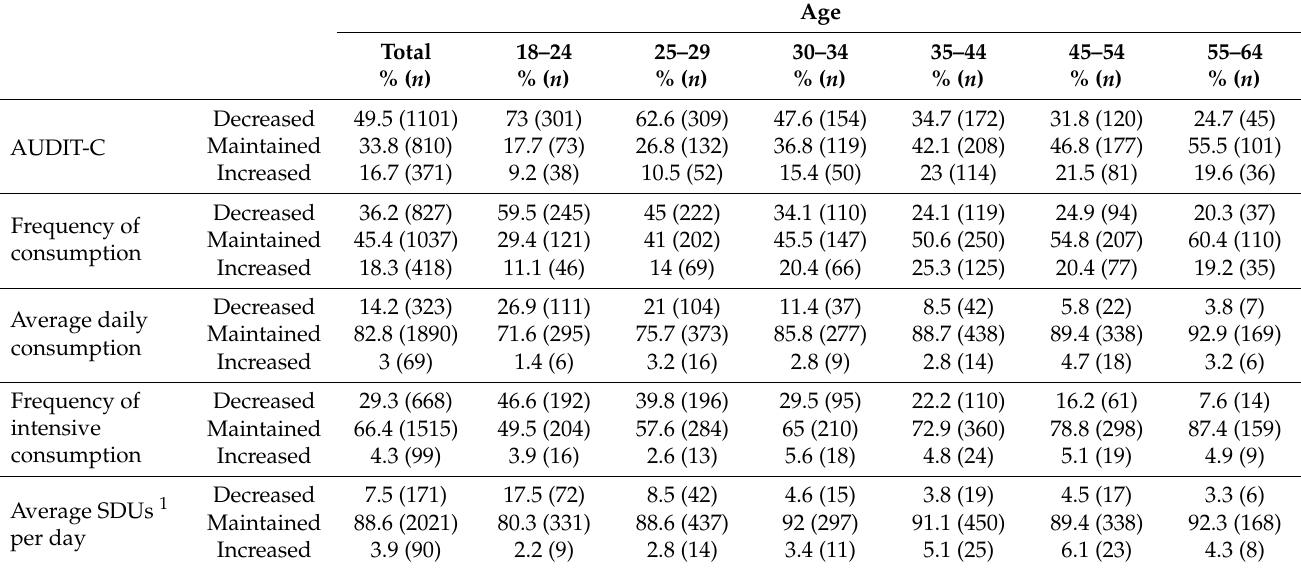
Table 1. Changes in alcohol consumption during confinement ( n =